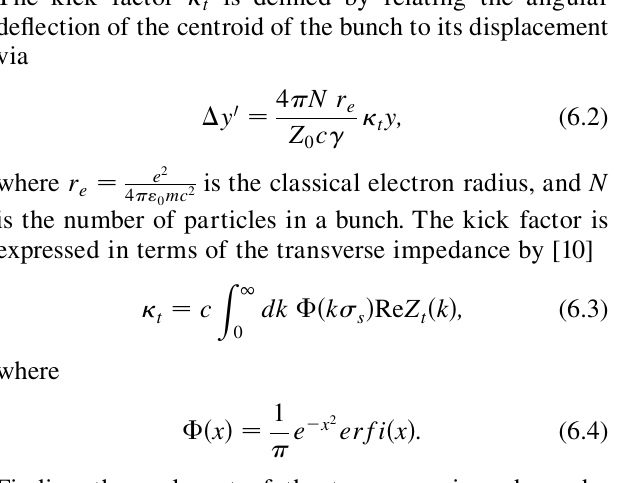
FIG. 7. The function K verse kick